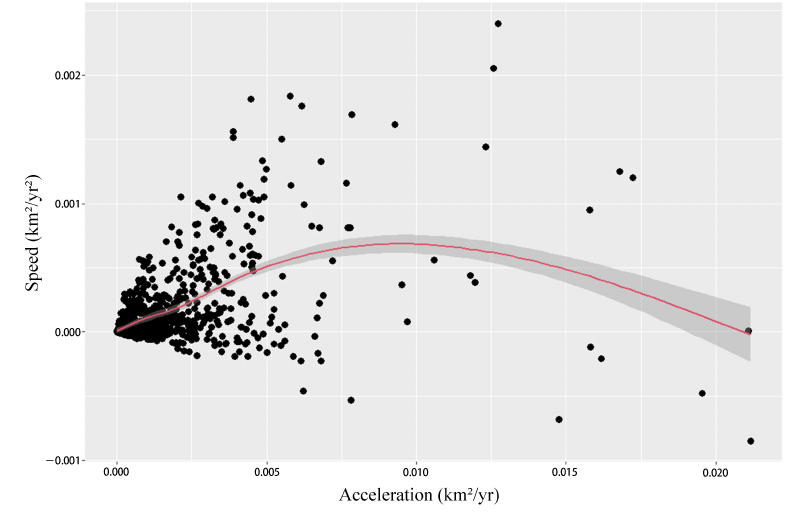
Figure 12. Relationship between speed and